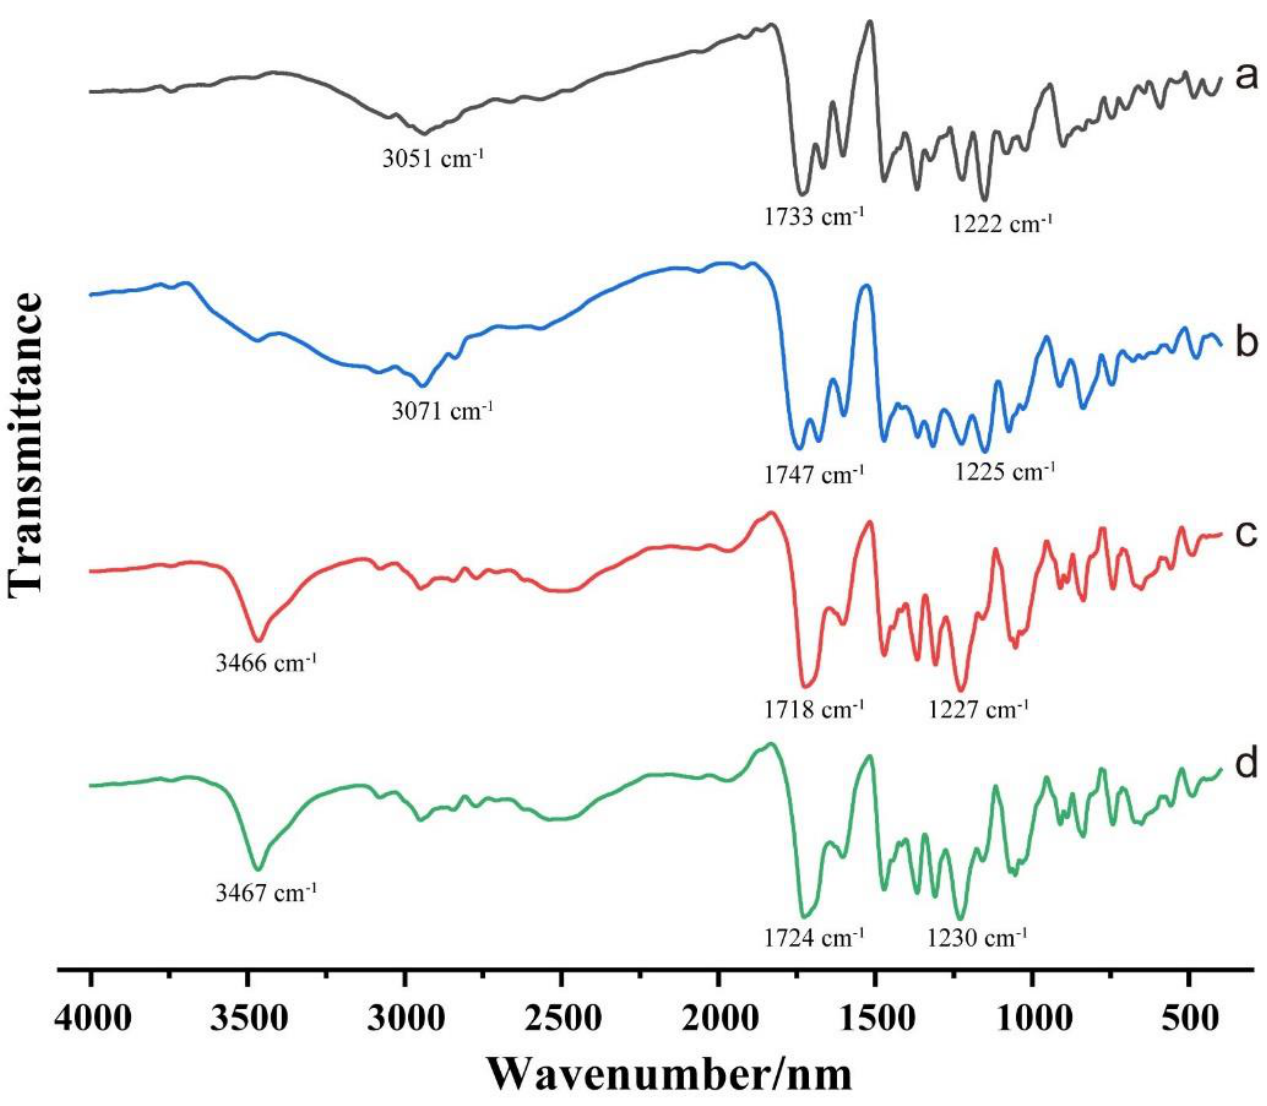
Figure 5. FT-IR spectra of ( a ) crystalline ACM, ( b ) amorphous ACM, ( c ) monohydrate ACM and ( d ) ACM gels.